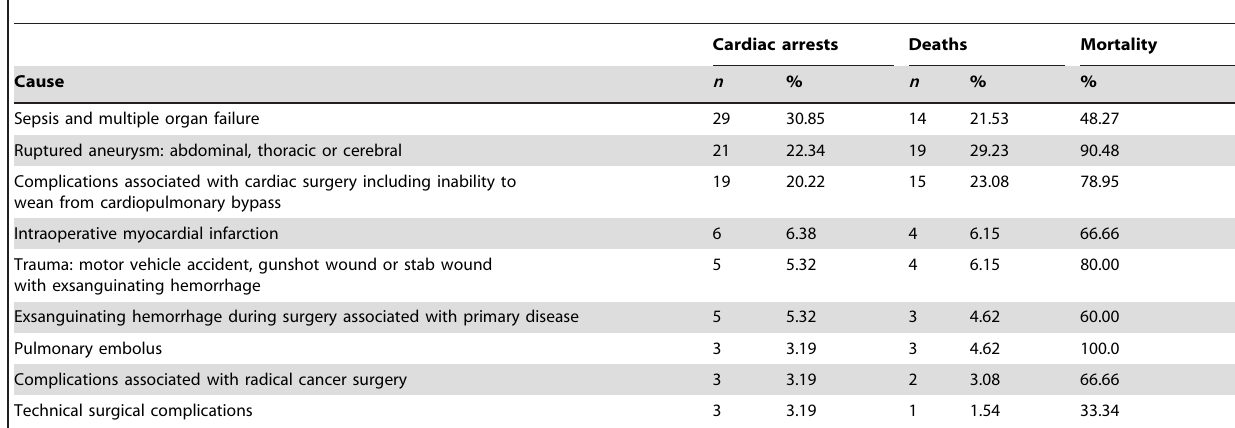
Table 6. Causes of intraoperative cardiac arrests and deaths attributed to an older patient’s disease/condition or surgical